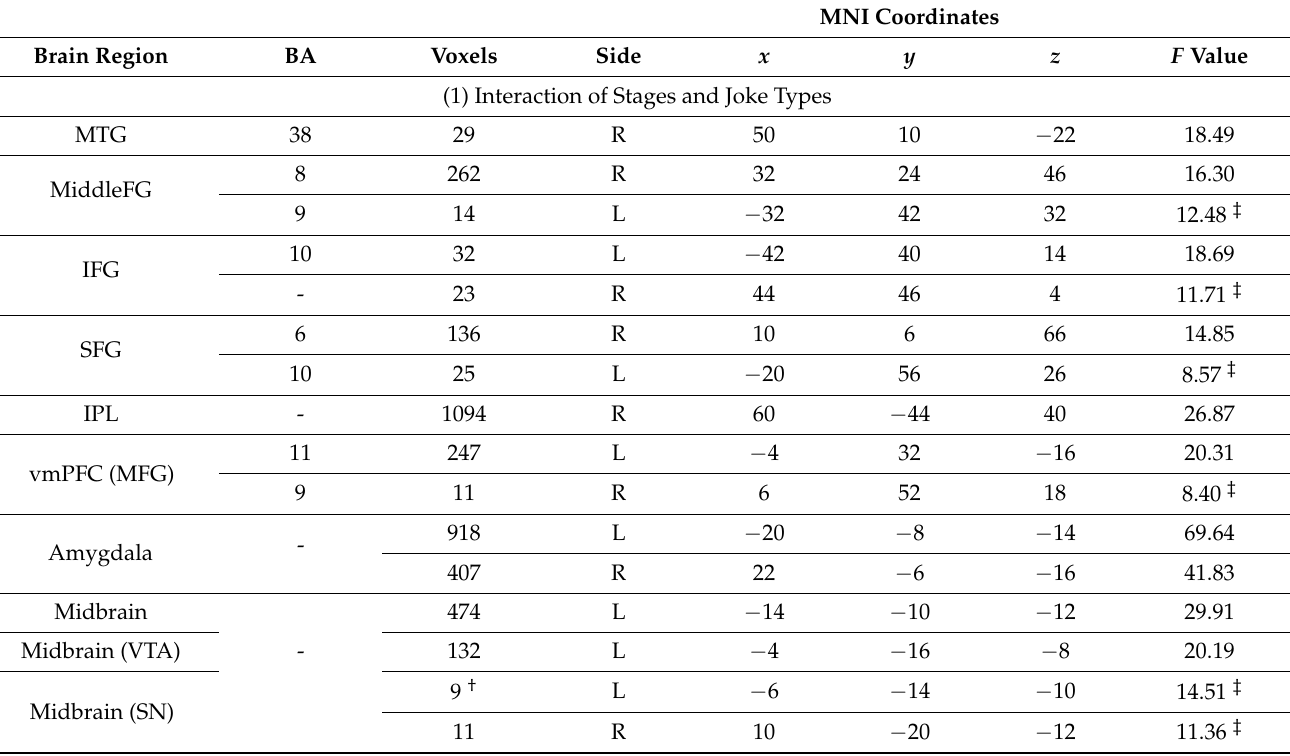
Table 4. Brain regions associated with interactions of the expectation, incongruity, and resolution- elaboration stages with joke types.